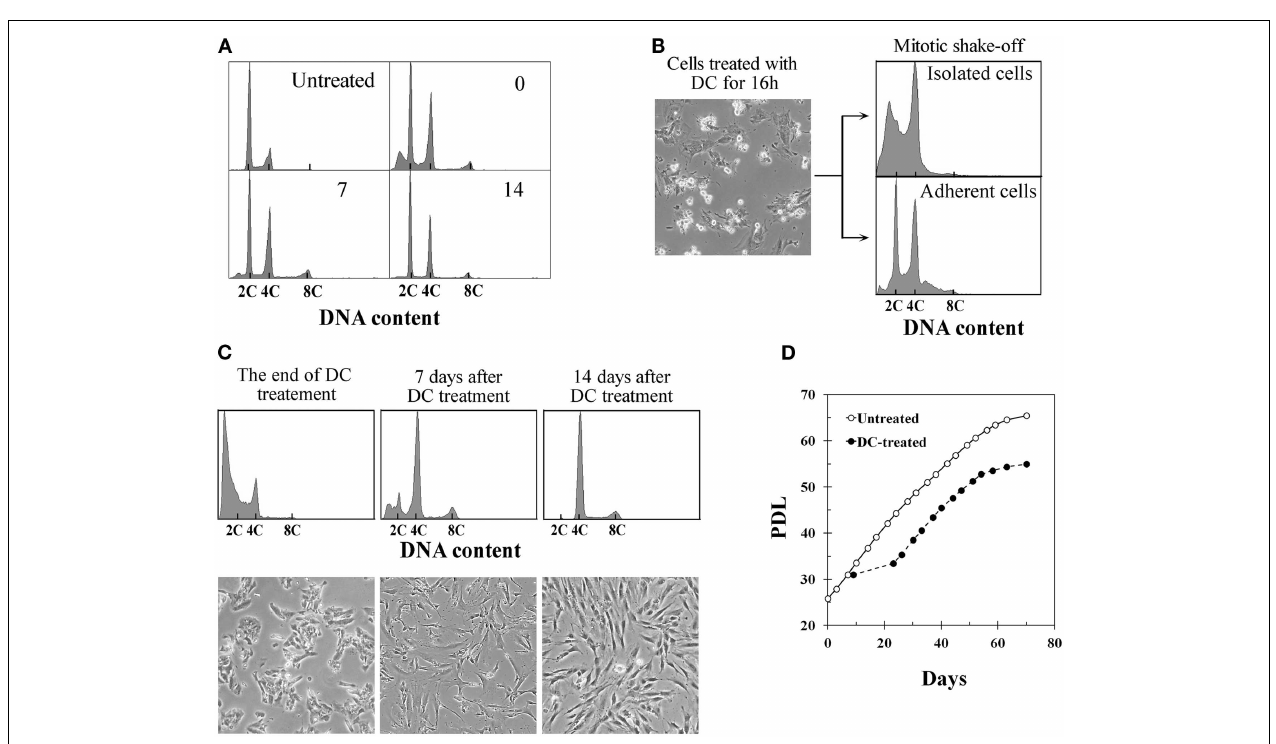
lower panel). (C) Changes in DNA histograms and morphology of cells isolated by the shake-off method. Upper panels show DNA histograms and lower panels show phase-contrast micrographs.The abscissa represents DNA content (C, complement). (D) Growth profiles of untreated BJ cells (open markers) and DC-treated cells (closed markers).The growth curve of DC-treated cells was made based on the observation that 10% of mitotic cells collected by shake-off had adhered to the dish at the end of DC